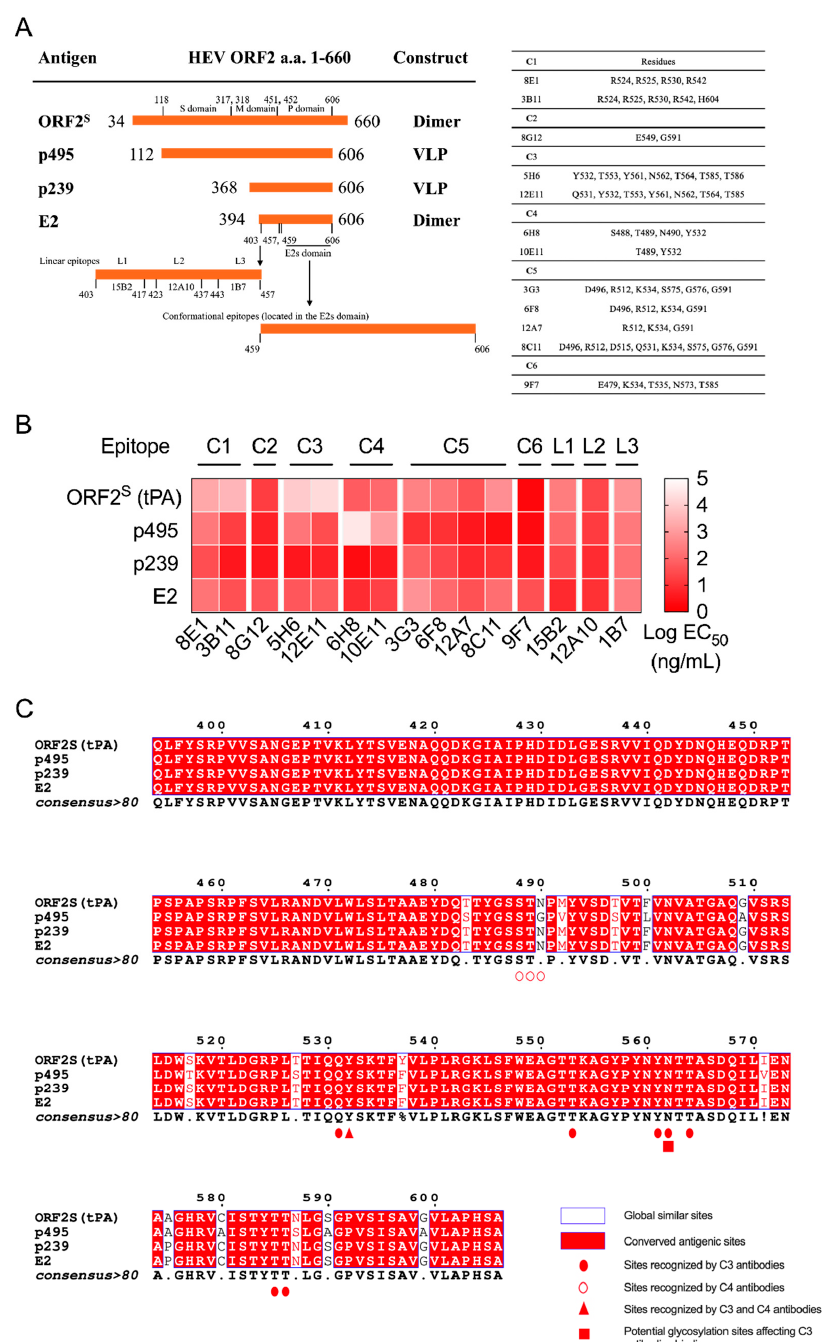
Figure 2. Comparison of immunoreactivity and epitope mapping in different HEV capsid proteins (ORF2 S , p495, p239, and E2). A panel of anti-ORF2 monoclonal antibodies (mAbs) that recognize nine different antigenic epitopes (C1-C6 and L1-L3) was used for detection. ( A ) Information on the four proteins and epitope regions recognized by a panel of mAbs (adapted with permission from Ref. [A Comprehensive Study of Neutralizing Antigenic Sites on the Hepatitis E Virus (HEV) Capsid by Constructing, Clustering, and Characterizing a Tool Box]. 2015, Zhao et al.). S domain, shell domain; M domain, middle domain; P domain, protruding domain; VLP, virus-like particles. ( B ) The panel of mAbs used was generated in a previous study [19]. Indirect ELISA was performed with a goat anti-mouse antibody (Thermo Scientific) as the visualized secondary antibody. The data shown are the concentrations that elicit 50% of maximal effect (EC 50 ). C1–C6, Cluster 1–Cluster 6;